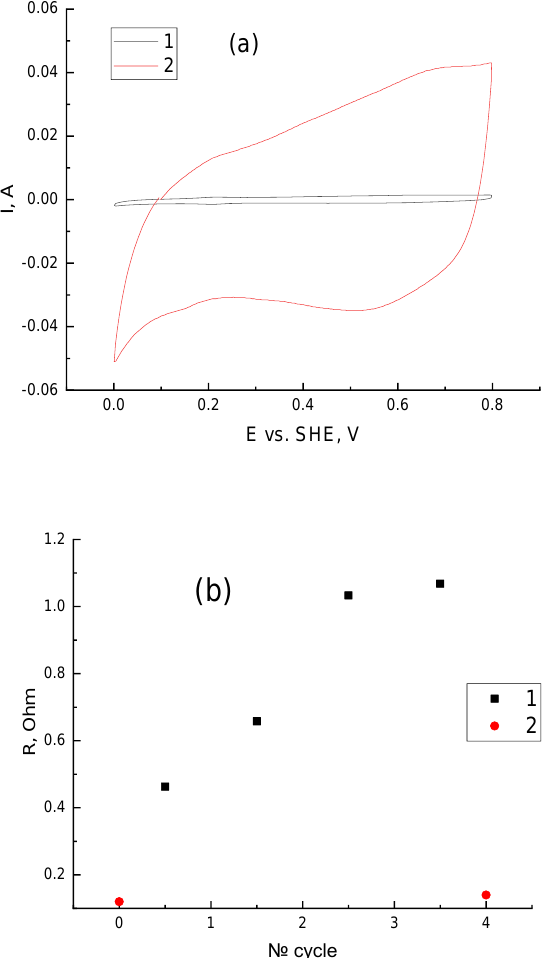
Figure 8. Comparison of characteristics of the H 2 -BrO 3 − flow battery before and after cyclic charge—discharge tests: ( a ) cyclic voltammetry plots of H 2 -BrO 3 − —flow batteries before (1) and after (2) cycling, 3 M H 2 SO 4 flux through the cathode, 0.5 L/h H 2 flux through the anode, sweep rate 20 mV/s, 3 cycles. ( b ) Points 1 (black squares): total resistance of the cell calculated from the voltage jump at the moment when the current is switched between the charge and discharge regimes for cycles 1 to 4; Points 2 (red circles): cell resistance before and after 4 charge—discharge cycles measured by the impedance method.